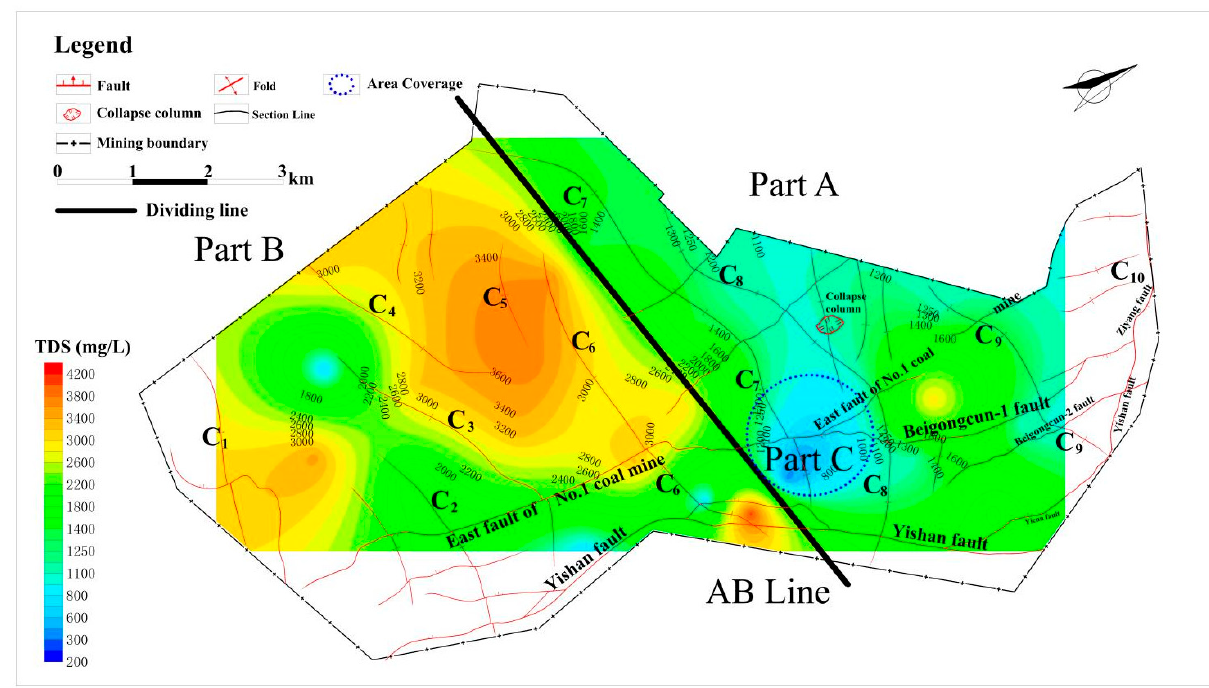
Figure 6. TDS Equivalent Diagram of the Ordovician aquifer in the Dongtan Coal Mine.